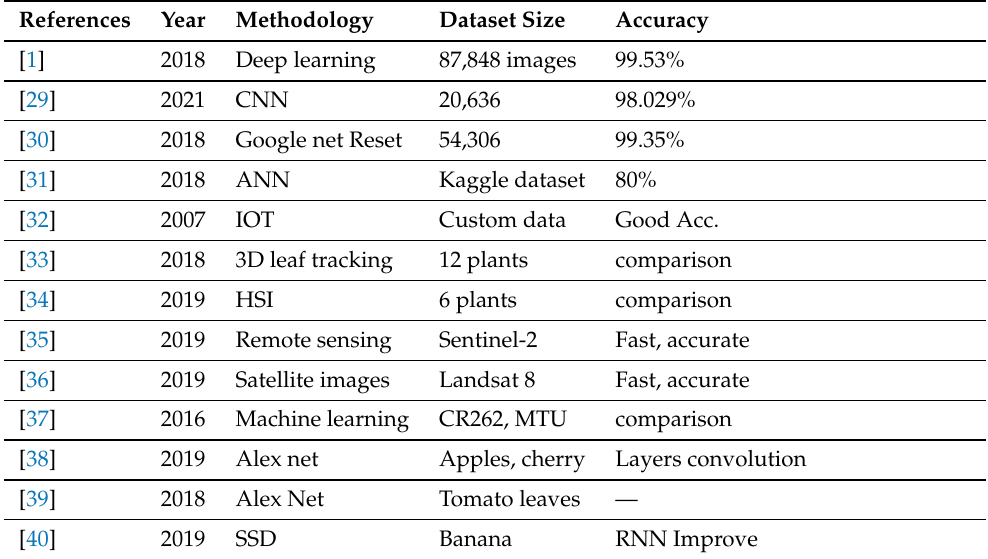
Table 1. Summary of related work on the identification of plant diseases.